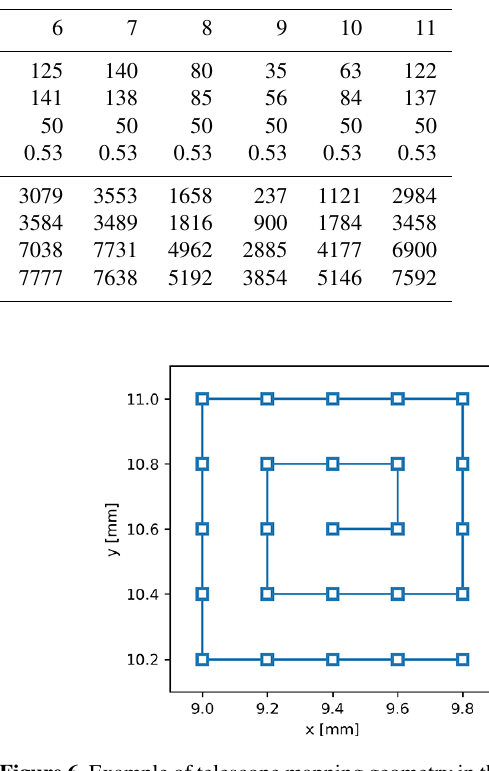
Figure 6. Example of telescope mapping geometry in the x – y plane (used for the first measurement session described in this work); x and y relative position of the servomotors in the respective axis.